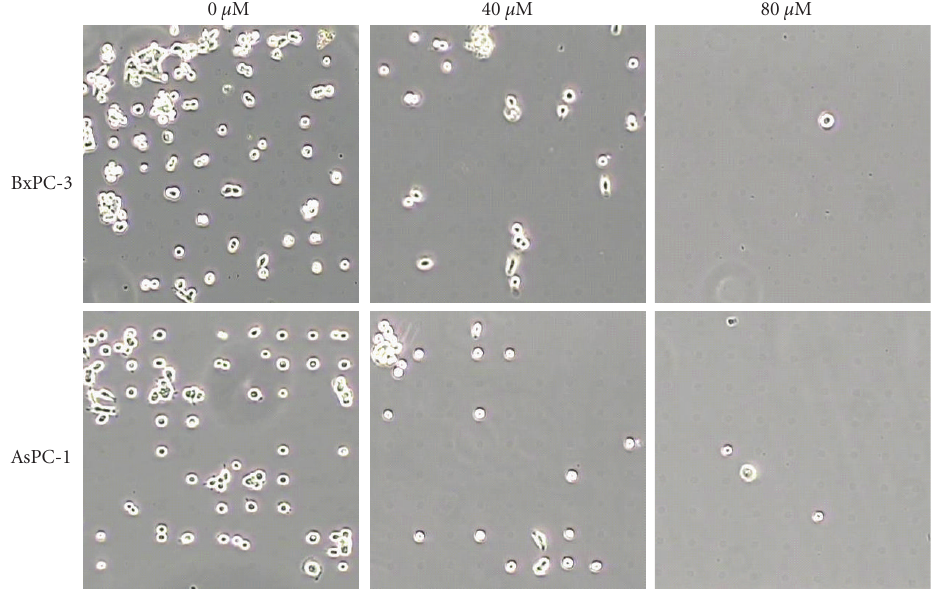
Figure 1: EGCG suppresses cell adhesion by micropattern assay. AsPC-1 and BxPC-3 cells were plated at a density of 0.8 × 10 5 cells/ml in the presence of indicated doses of EGCG onto micropattern coverslips as described in the Materials and Methods. After 24 hours, cells attaching to single dots were photographed under